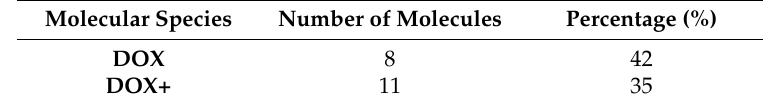
Table 2. Average number and degree of penetration of drug molecules within the HBP’s structure.